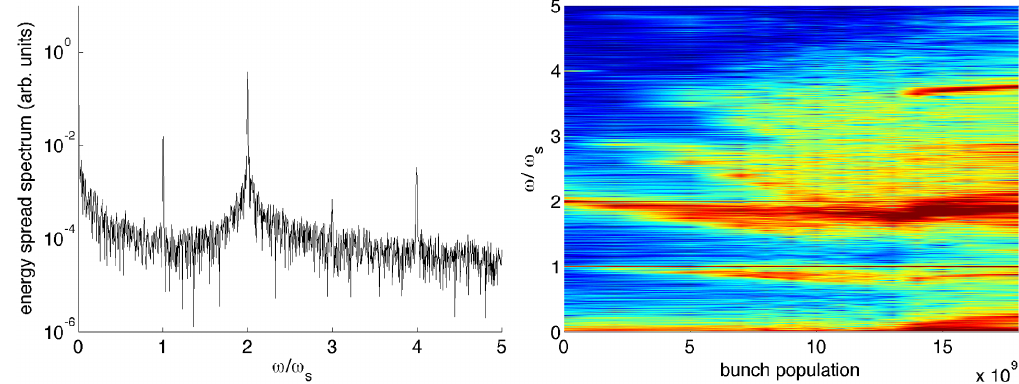
FIG. 10. Amplitude of the energy spread spectrum of the zero intensity bunch (left side). Mode spectrum as a function of bunch intensity (right side). Red-black colors correspond to higher amplitude, blue to lower amplitude.